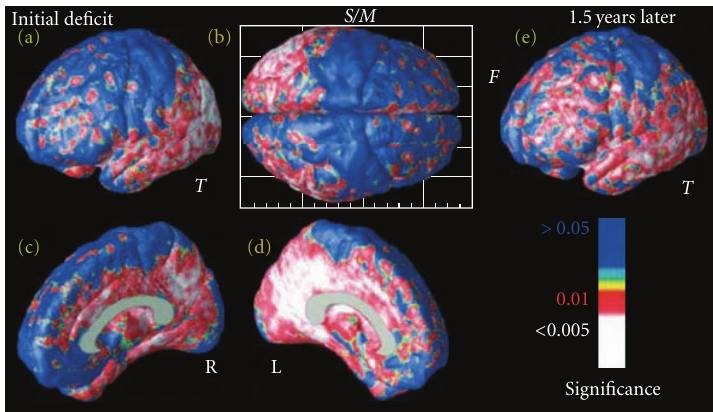
Figure 12: Mapping links between cognitive performance and changing brain structure. These maps show the significance of the linkage between gray matter reductions and cognition, as measured by MMSE score. Variations in temporal, parietal, and ultimately frontal (e) tissue are linked with cognitive status. Less gray matter is strongly correlated with worse cognitive performance, in all regions with prominent deficits. Linkages are detected most strongly in the left hemisphere medial temporoparietal zones (d). As expected, no linkages are found with sensorimotor gray matter variation (b), which was not in significant deficit in late AD (adapted with permission from [39]).